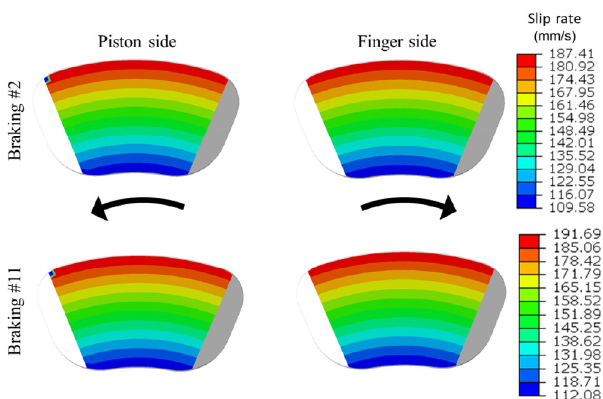
Fig. 7 Slip rate of braking #2 and #11 in Table 2. Arrows show the disc sliding direction.